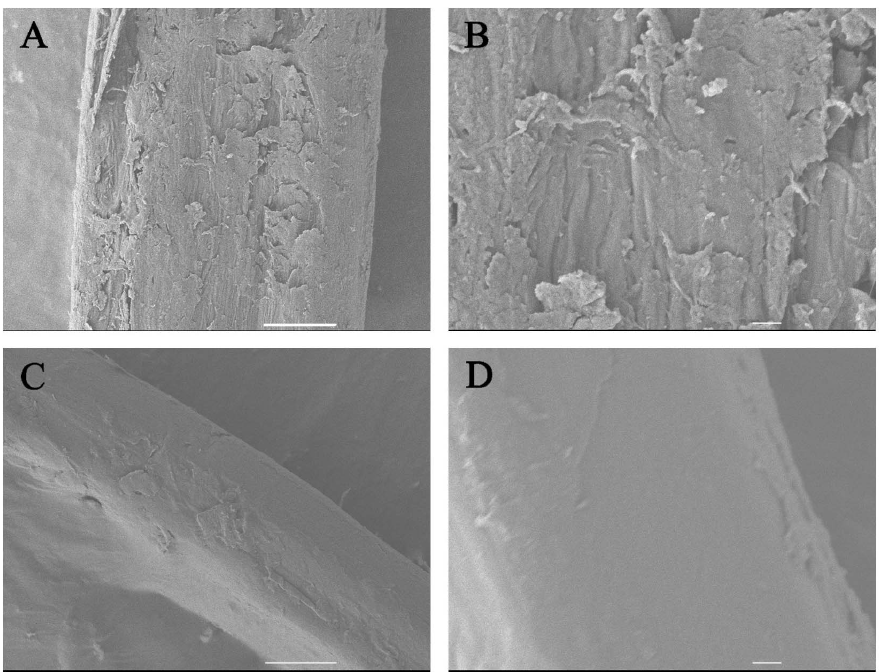
Figure 8. Scanning electron microscopy of ramie fibers bast before (A, B) and after treatment with crude PGL (C, D). Scale bars: 10 m m (A, C) and 1 m m (B, D).